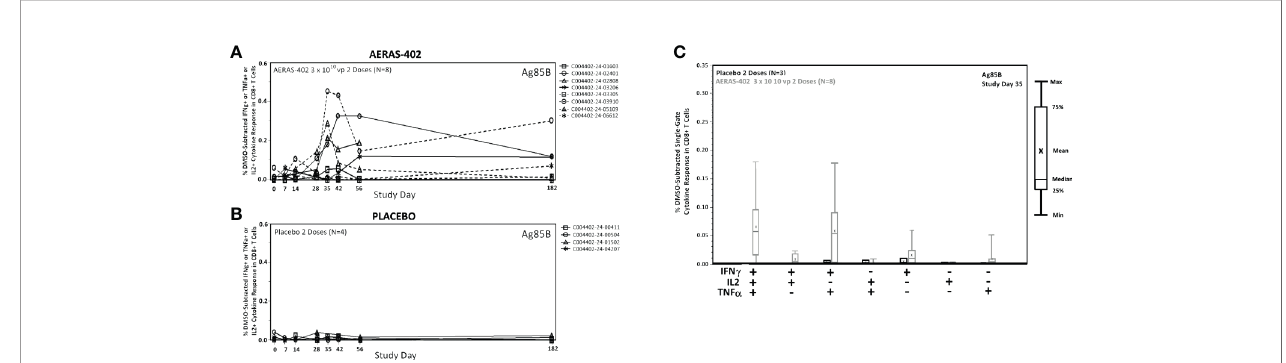
FIGURE 3 | CD8 + cytokine responses to Ag85B. PBMCs were thawed, rested overnight, and stimulated for 5-6 hours with DMSO (negative control), SEB (positive control), or peptide pools corresponding to the vaccine antigens Ag85A, Ag85B, or TB10.4. Specimens were then stained for viability, phenotypic markers, and intracellular cytokine expression and evaluated by fl ow cytometry. Data was analyzed using Flow Jo software to generate cytokine Boolean gates. Each gate was subjected to DMSO subtraction to remove background. Negative results following background subtraction are set to zero. The sum of these gates was then used to determine the total cytokine response for vaccinated (A) and placebo control (B) groups or plotted by functionality to assess the polyfunctional response (C) . Lines (A, B) are plotted for each individual subject. CD8 + Single-Gate (Boolean; C ) ICS responses for Ag85B at Study Day are shown for vaccinated (gray bars) and placebo (black bars) groups. Bars represent the 25 th to 75 th percentile, with the cross bar representing the median response. The Mean is indicated by an “ x ” and the error bars represent the minimum and maximum responses.